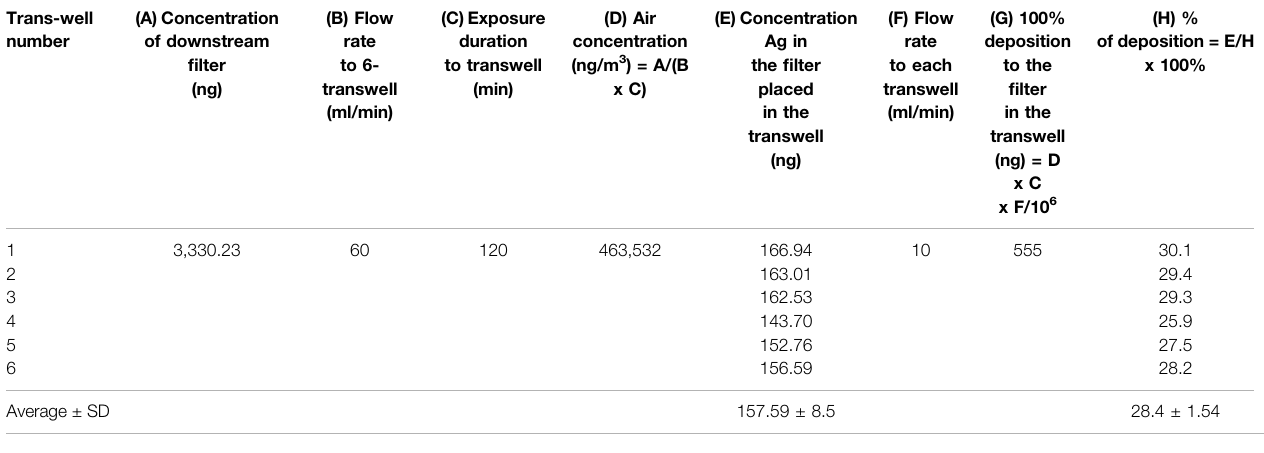
TABLE 2 | Deposition rate of 20 – 30 nm AgNP nanoaerosols to the transwell. Trans-well number